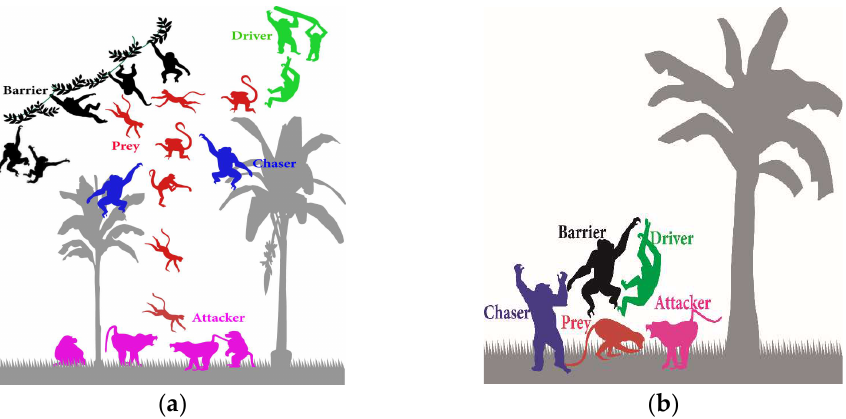
Figure 4. Hunting process in ChOA. ( a ) First phase: exploration, which consists of blocking, driving, and chasing the prey; ( b ) Second phase: exploitation, which consists of attacking the prey. Driving and chasing the prey are formulated as Equations (1)–(5).